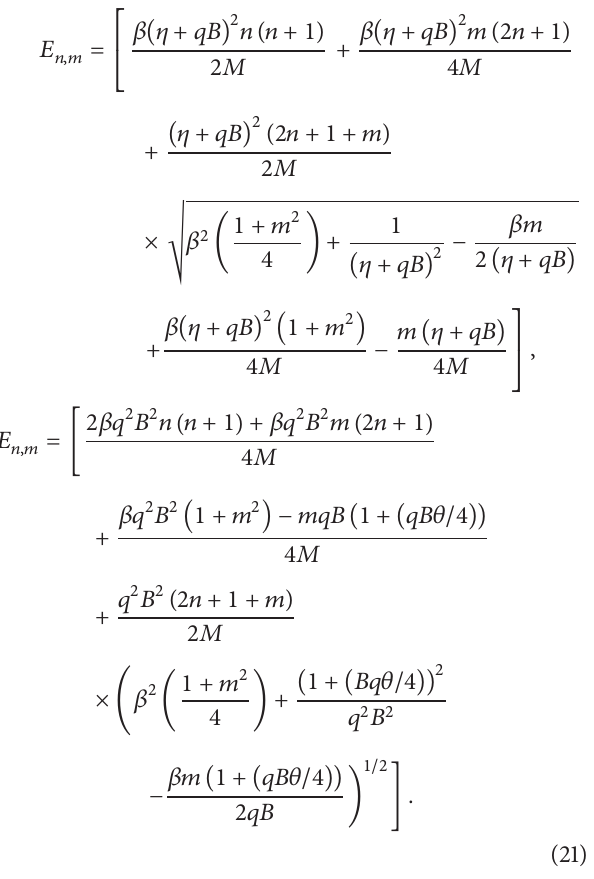
𝜂 = 0 , that is, for vanishing NCPS parameters, respectively, yields